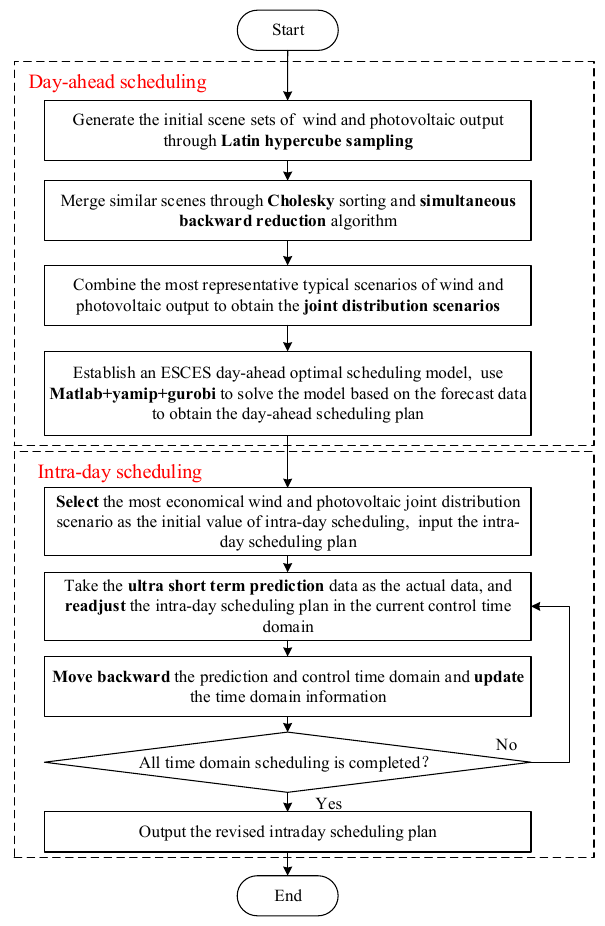
Figure 3. Two ‐ time scale scheduling solving